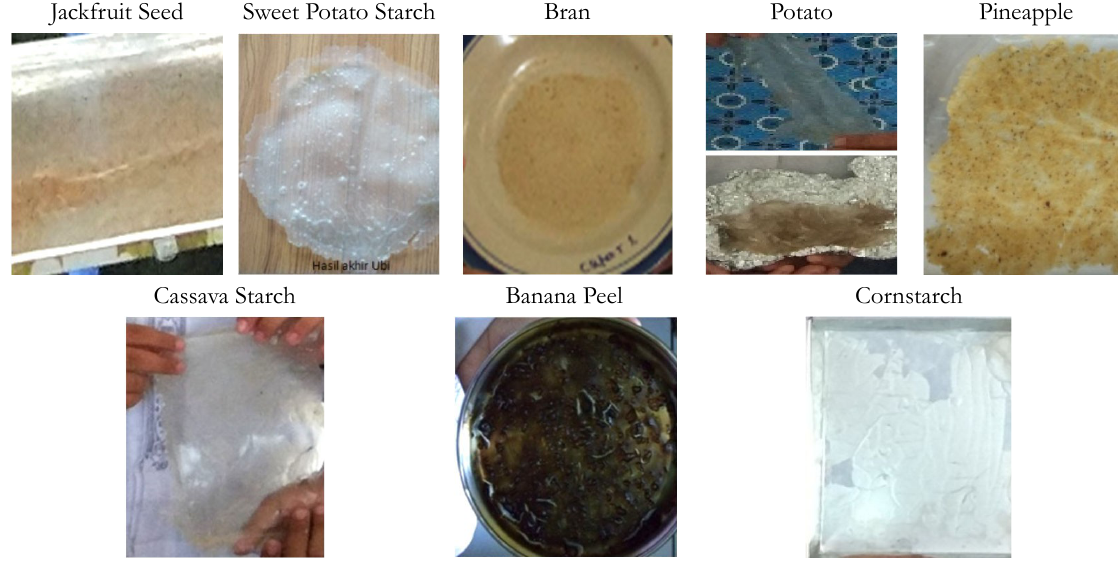
Figure 8. Biodegradable plastic products produced by the